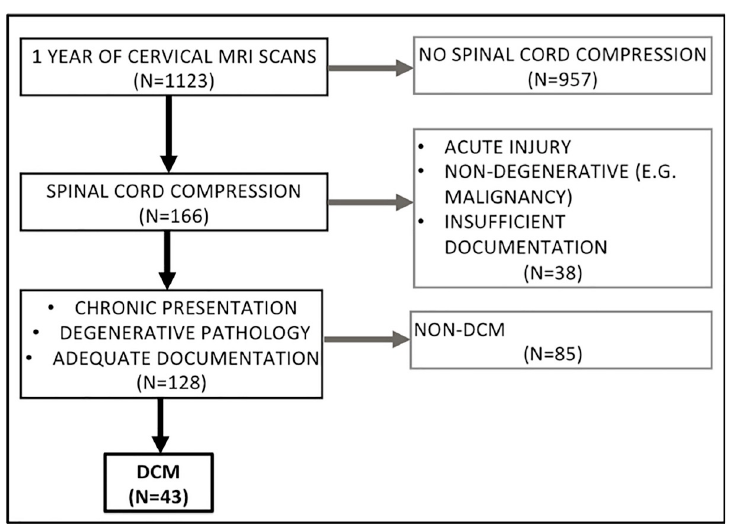
Fig 1. PRISMA flow diagram depicting cohort formation